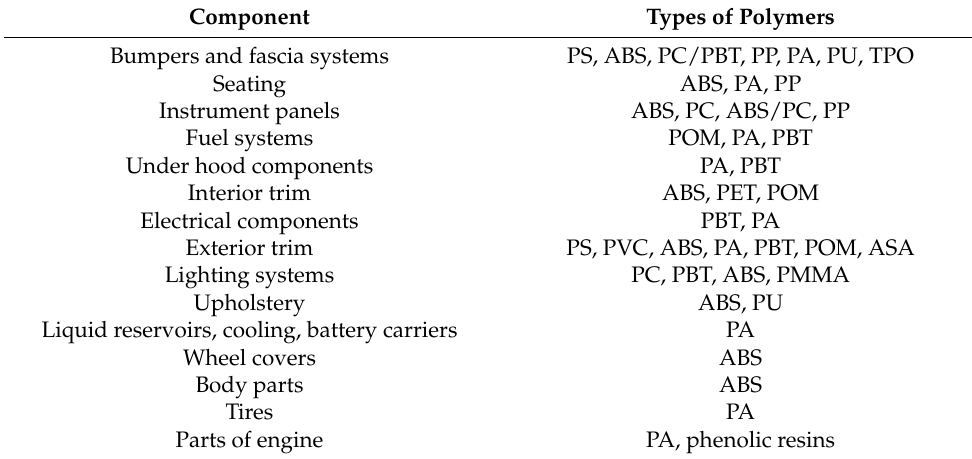
Table 1. Common plastics used in a typical car. Component Types of Polymers Bumpers and fascia systems PS, ABS, PC/PBT, PP, PA, PU, TPO Seating Instrument